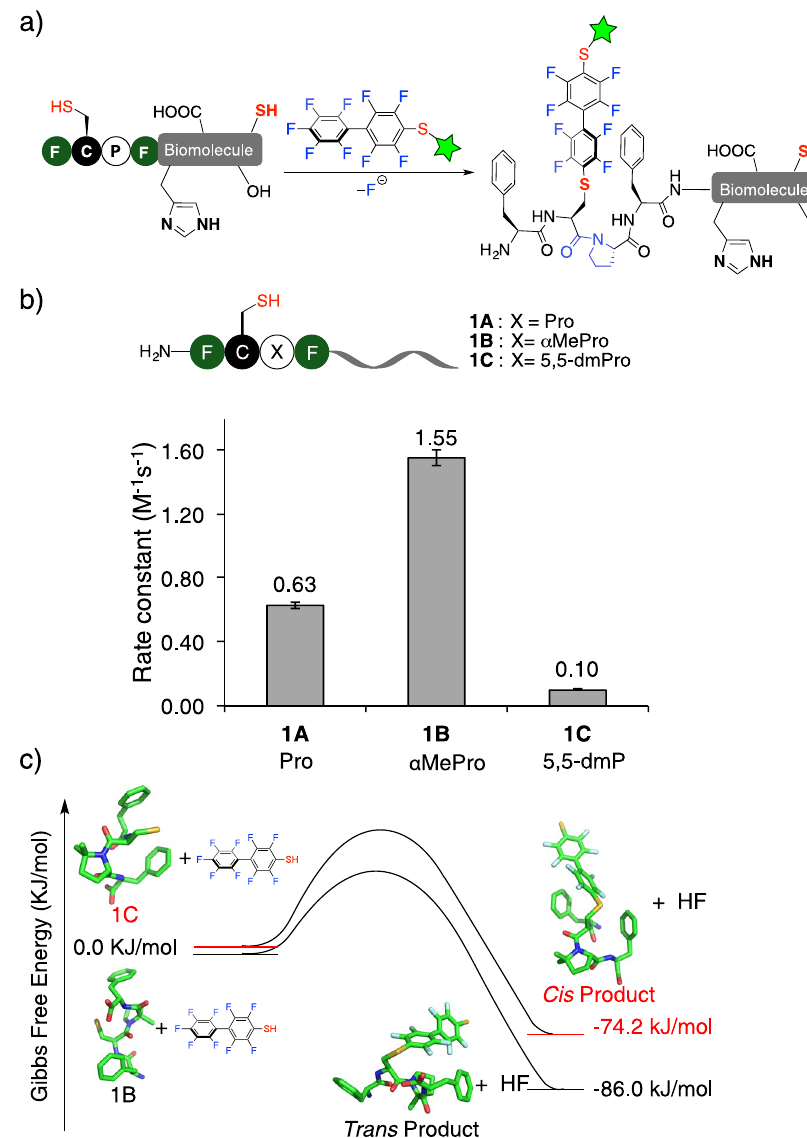
Figure 1. Trans conformation of the Cys-Pro amide bond is critical for π -clamp-mediated arylation. ( a ) Scheme of π -clamp-mediated cysteine arylation. ( b ) Reaction rate of π -clamp-mediated arylation is influenced by proline mutation. Peptides 1A – 1C were reacted with probe 2 . Reaction conditions: 200 mM phosphate, 20 mM TCEP, pH 8.0, 37 °C. ( c ) Calculated Gibbs free energy changes of the perfluoroarylation reaction involving trans Pro π -clamp mutant ( 1B , black) and cis Pro π -clamp mutant ( 1C , red). Representative computed geometries of the π -clamp mutants ( 1B and 1 C ) and the perfluoroarylated products used in the DFT calculation are also